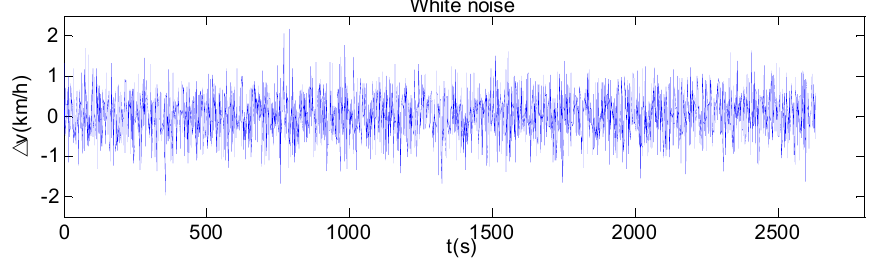
Figure 23. Noise1 for the driving cycle. Energies 2016 , 9 , 919